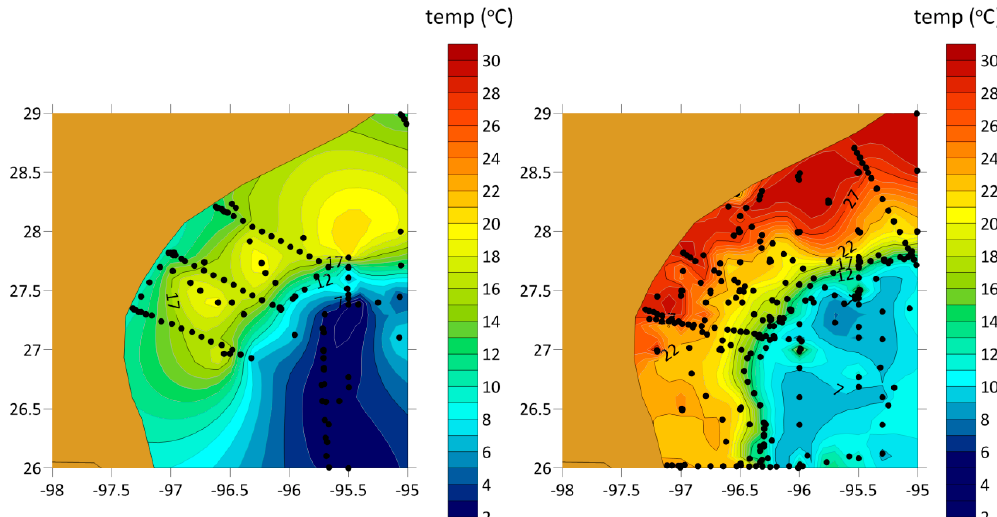
Figure 5. Bottom water temperatures in February ( left ) and August ( right ) off the Texas coast.